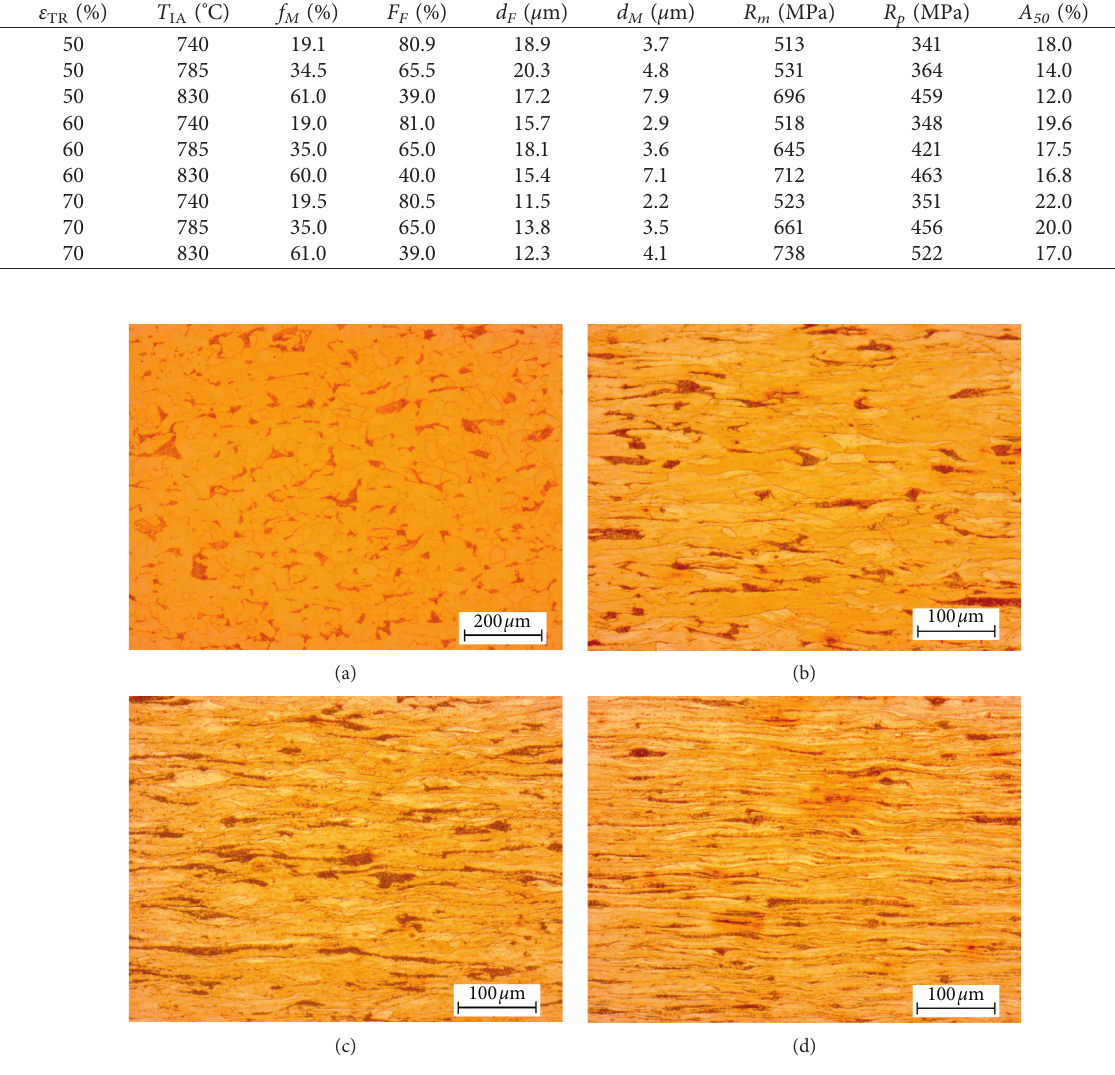
Figure 4: Microstructure of studied steel at different thickness reductions: (a) 0%; (b) 50%; (c) 60%; (d)